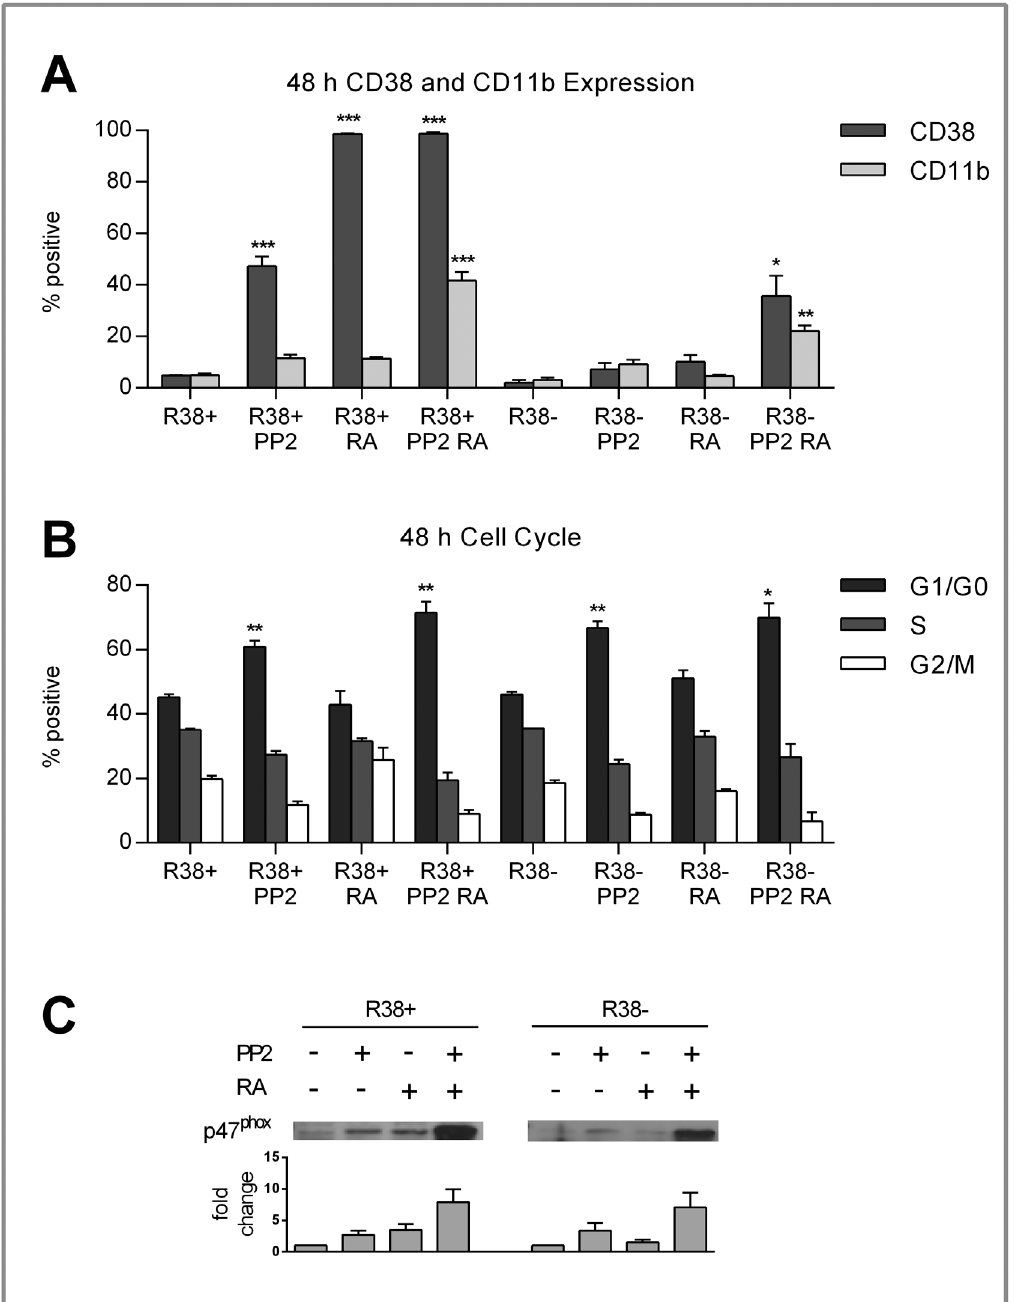
Figure 4. CD38 and CD11b expression, cell cycle progression, and p47 phox expression in control, PP2- and/or RA-treated R38 + and R38 2 HL60 cells. Error bars represent standard error of at least three repeats. P values were calculated using a student’s t test and are compared between untreated respective control unless otherwise indicated. A: Control, RA-treated and/or PP2-treated R38 + and R38 2 HL60 cells were labeled with PE-conjugated CD38 and APC-conjugated CD11b and analyzed by flow cytometry. To measure the percent positive signal, controls were set to exclude 95% of the live cell population peak. After 48 h, PP2 induced significant (p , 0.001) CD38 expression ( , 50%) in R38 + . Combined PP2 + RA treatment in R38 + significantly increased (p , 0.001) CD11b to levels comparable with those of RA-treated WT HL60 cells ( , 40%). In R38 2 , co- treatment resulted in diminished yet still significant increases CD38 (p , 0.05, nearly 40%) and CD11b (p , 0.01, more than 20%) expression. PP2 treatment alone had no significant effect on CD38 or CD11b expression in R38 2 . B: To assess cell cycle progression, control and RA-treated WT, R38 + and R38 2 HL60 cells were stained with propidium iodide-hypotonic solution and analyzed by flow cytometry. Controls were gated to approximately 45% G1/G0 phase, 35% S phase and 20% G2/M phase. PP2 induced growth arrest (more than 60%) in both R38 + (p , 0.01 alone and with RA) and R38 2 (p , 0.01 with PP2 alone, p , 0.05 with co-treatment). C: p47 phox expression was upregulated in both R38 + and R38 2 with combined PP2 + RA treatment. PP2 alone did not increase p47 phox expression greater than RA treatment alone in either R38 + or R38 2 .